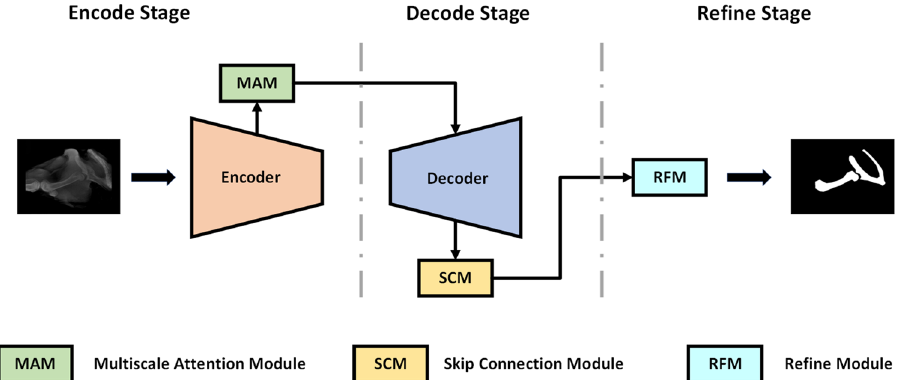
Figure 1. The general architecture of the proposed